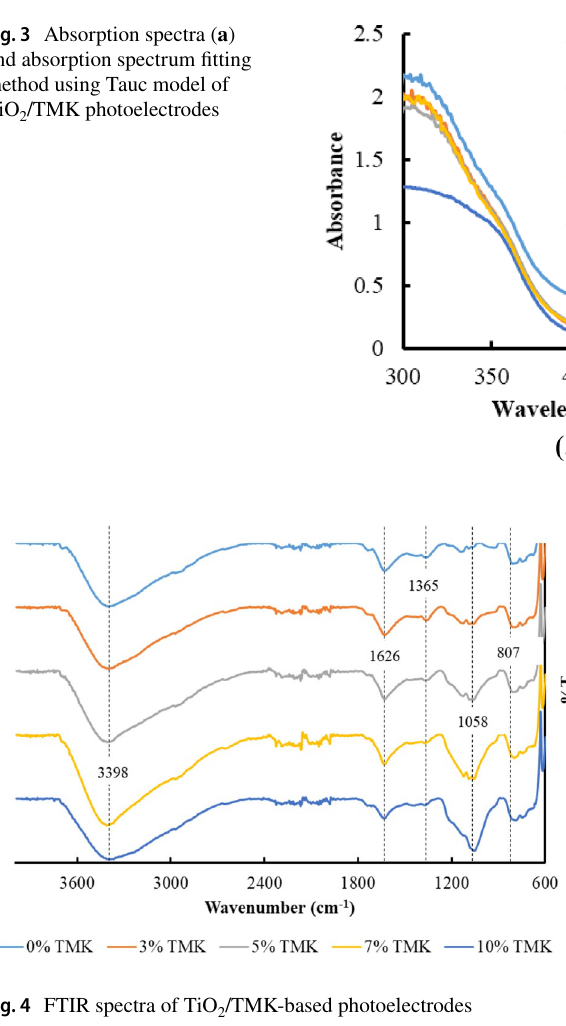
Fig. 4 FTIR spectra of TiO 2 /TMK-based